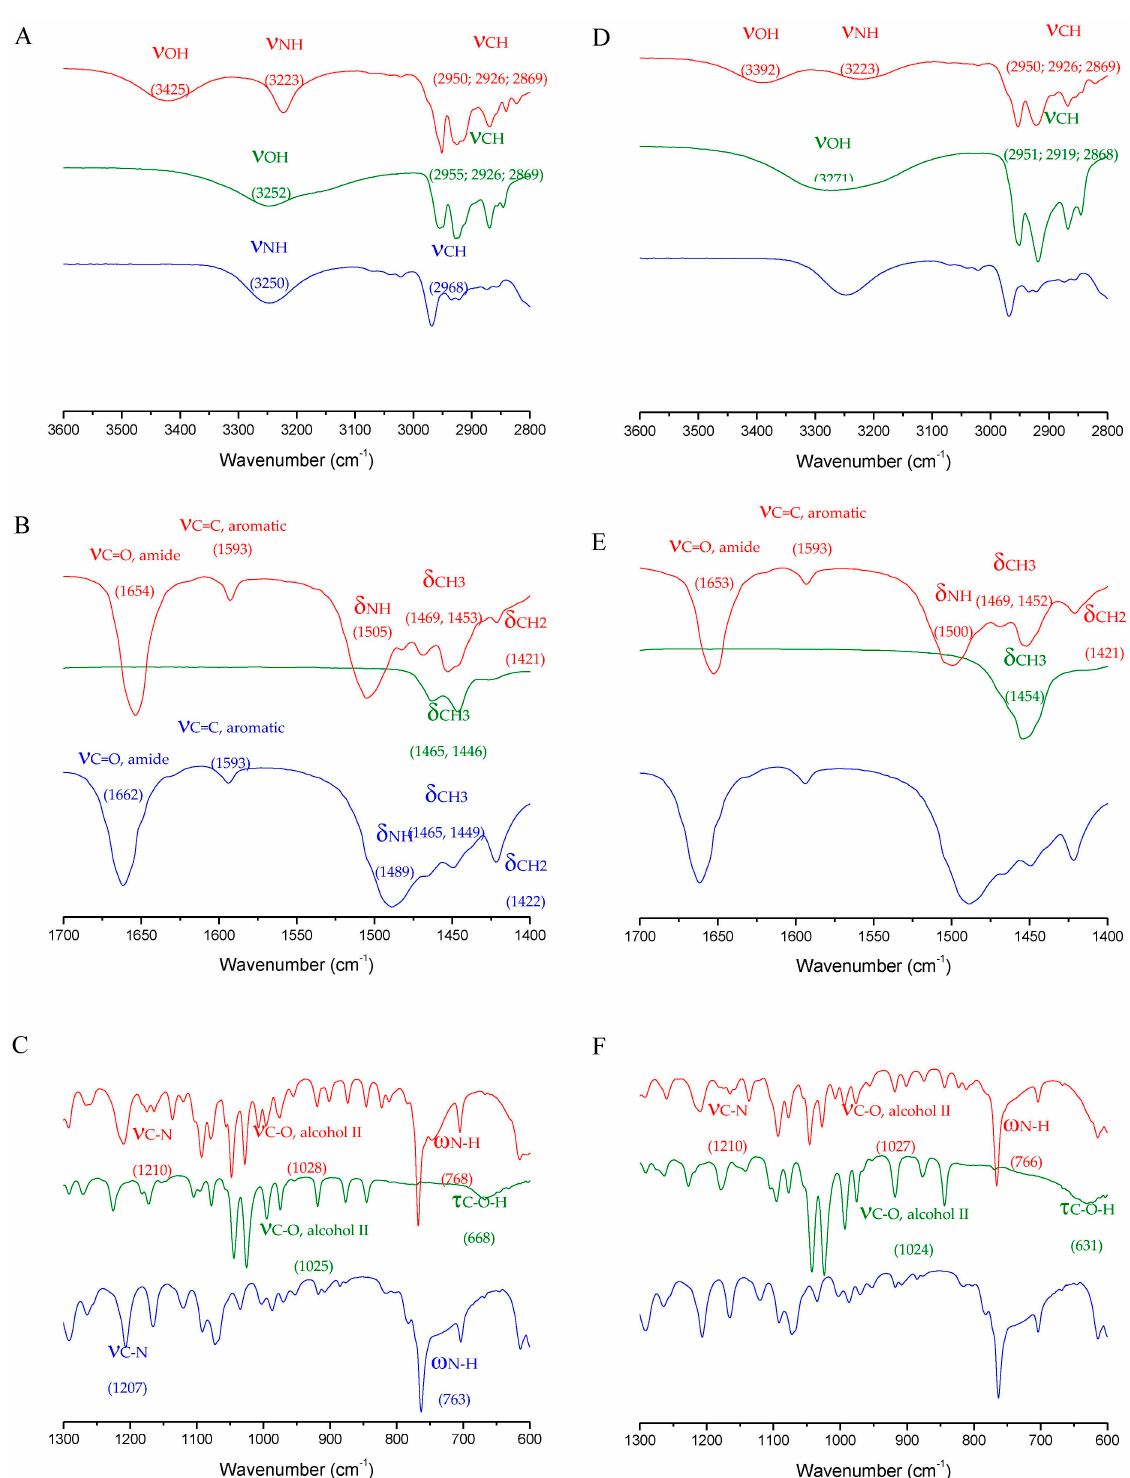
Figure 4. Infrared spectra obtained for the L - ( left column , red curves) and DL -menthol-based ( right column , red curves) cocrystals. Infrared spectra for lidocaine (blue curves) and menthol (green curves, i.e., L - and DL -menthol in the left and right columns, respectively) have been presented for comparison. The curves have been shifted for clarity. ( A , D ), ( B , E ), and ( C , F ): spectra in the 3600–2800, 1700–1400, and 1300–600 cm − 1 wavenumber regions, respectively. The most important peak attributions are proposed on the curves with, the related wavenumber proposed in brackets in cm − 1 .